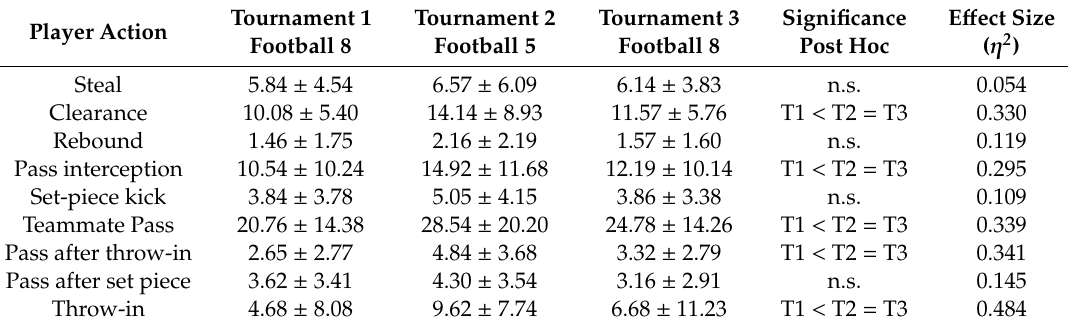
Table 2. Technical-tactical actions through which the ball is received.